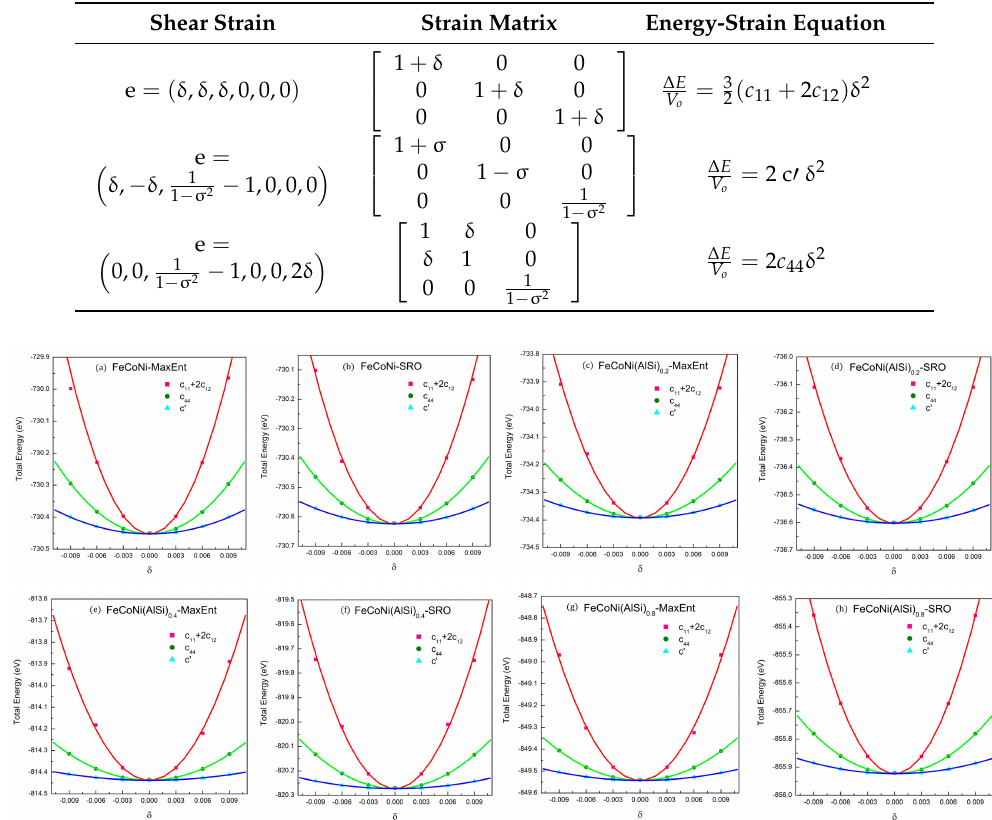
Figure 6. The total energies curves of different deformations for c 11 + 2c 12